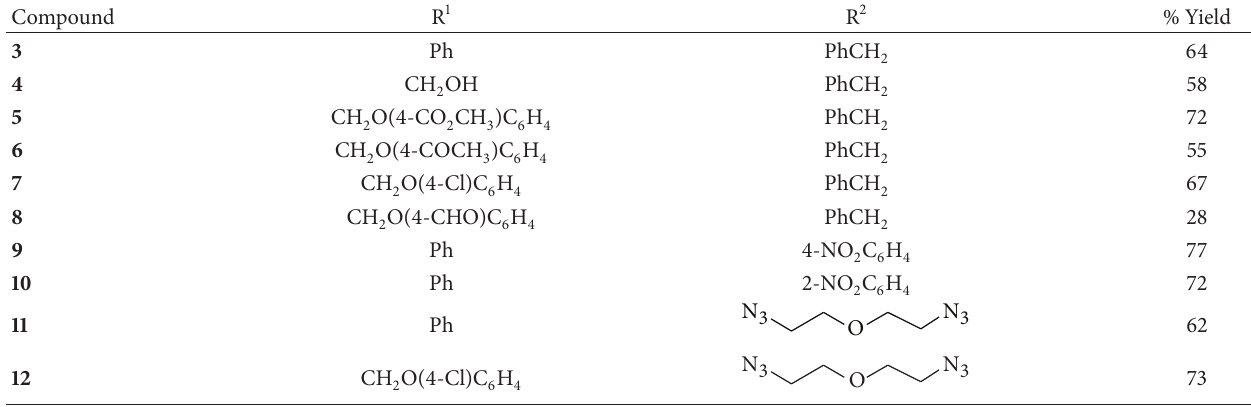
Table 2: Synthesis of triazoles catalyzed by silver